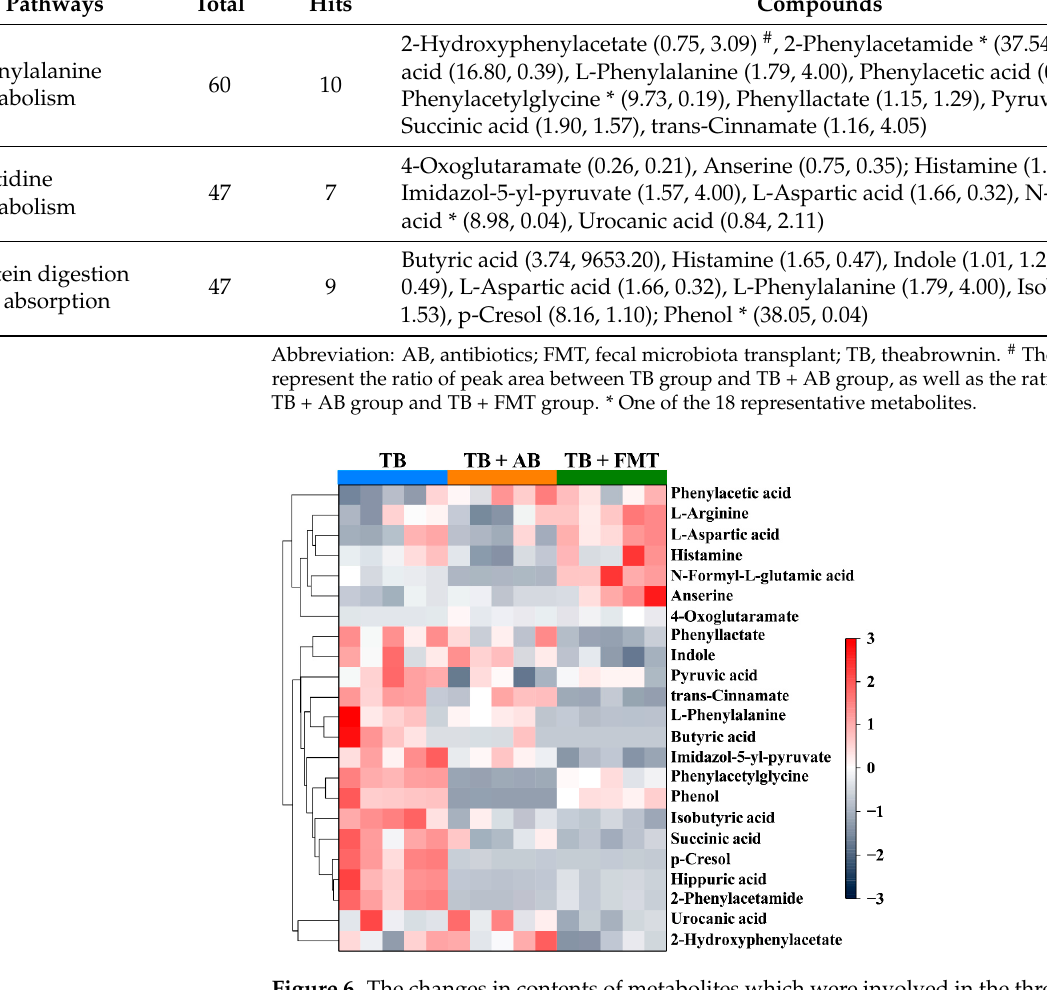
Figure 6. The changes in contents of metabolites which were involved in the three common meta- bolic pathways. Abbreviation: AB, antibiotics; FMT, fecal microbiota transplant; TB,